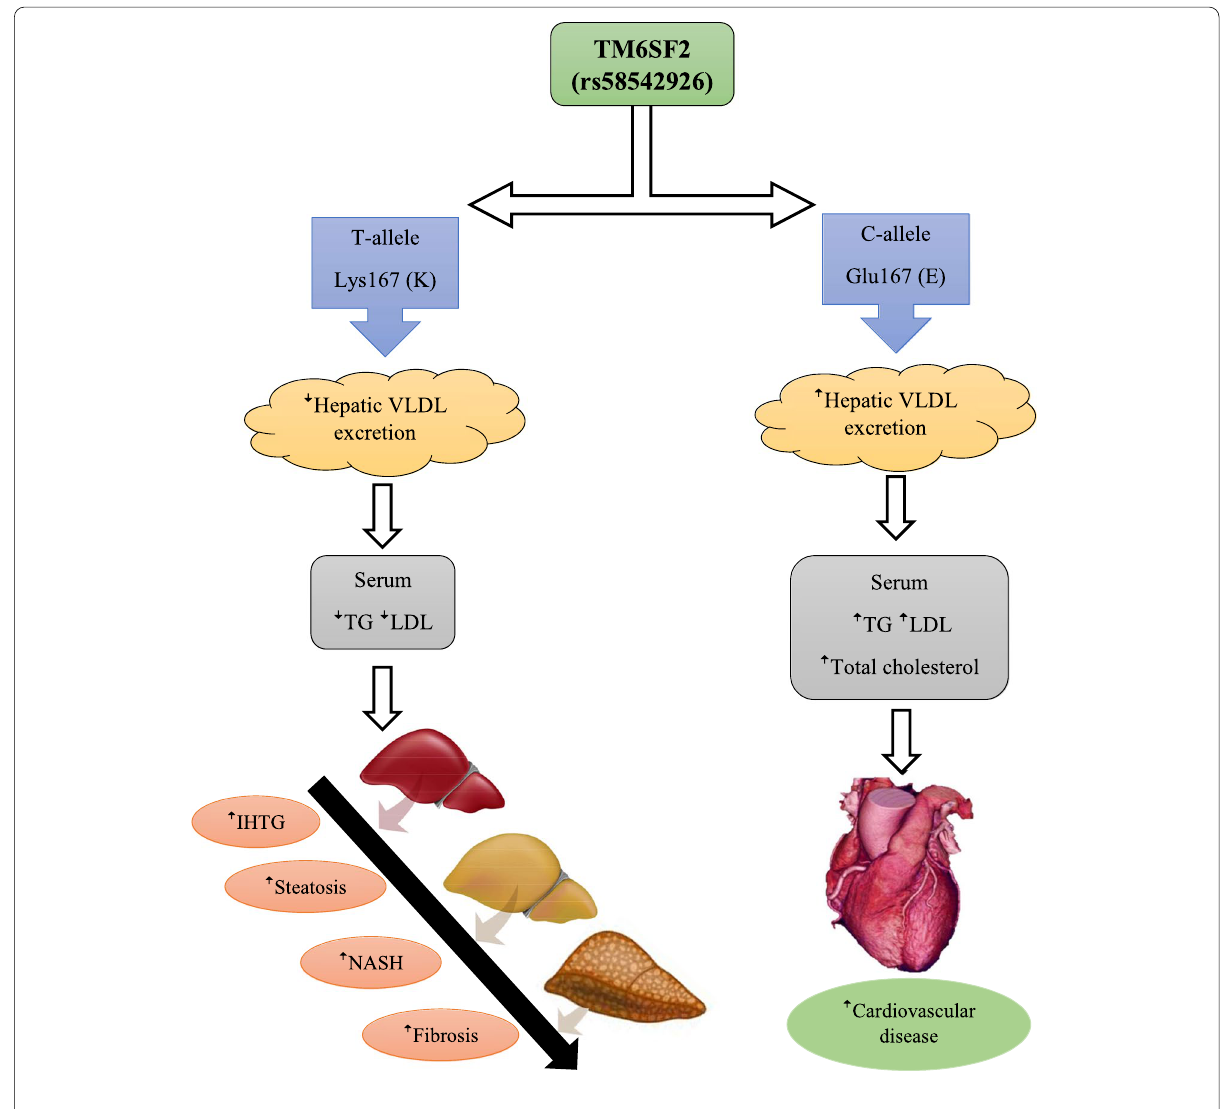
Fig. 10 Effects of TM6SF2 genetic